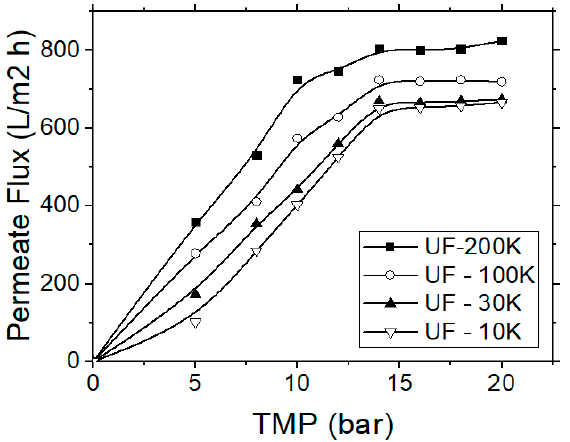
Figure 4. Permeate flux variation vs. the applied trans-membrane pressure (TMP) for the application of the ultrafiltration (UF) process, regarding the treatment of simulated tannery wastewater.